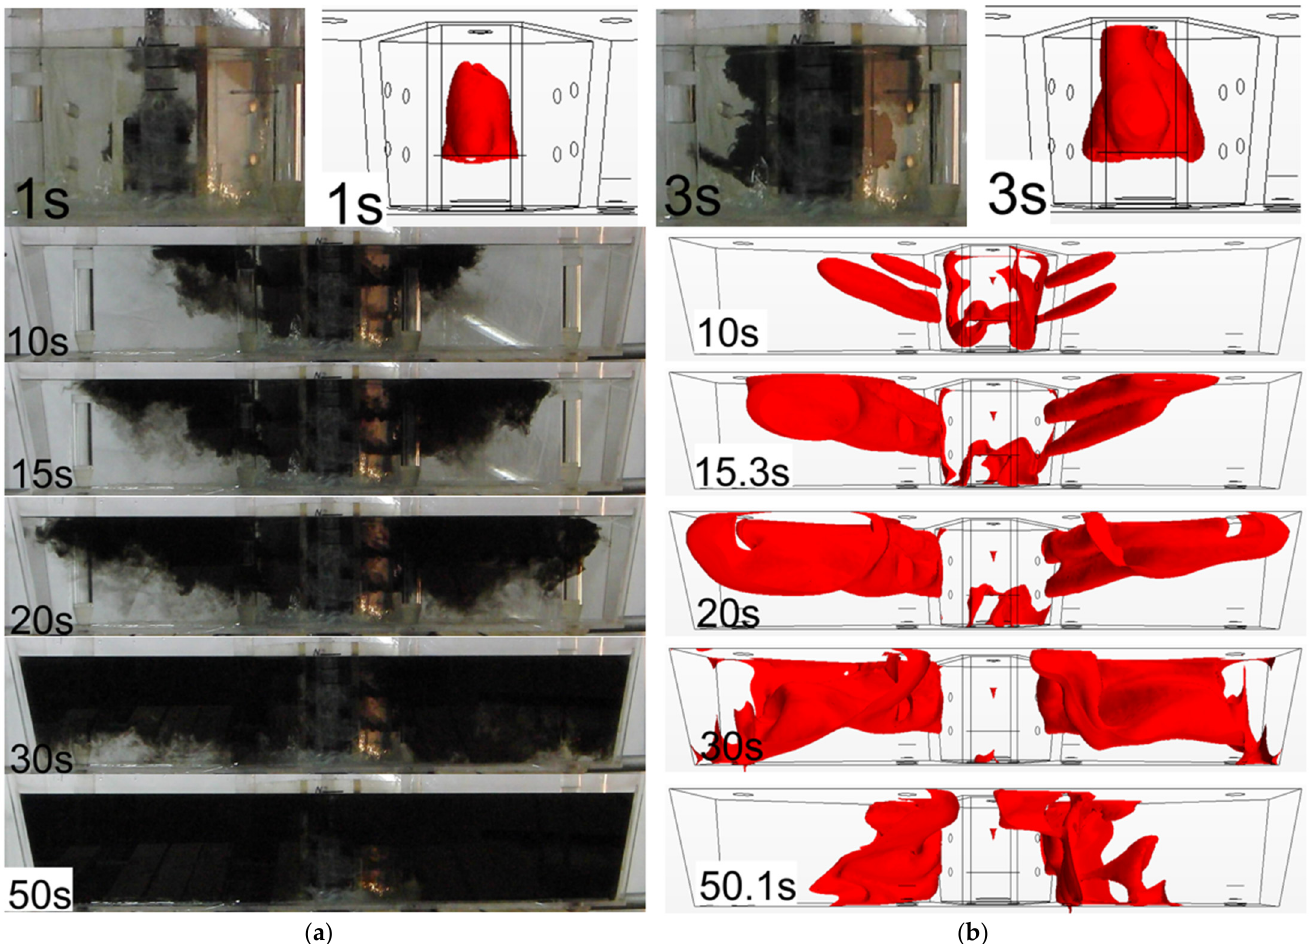
Figure 6. Comparison of ink diffusion photographs in water model and isosurface ( ω = 10 − 5 ) figures of numerical simulation results of u-shaped weir tundish: ( a ) ink diffusion photographs, ( b ) isosurface figures.